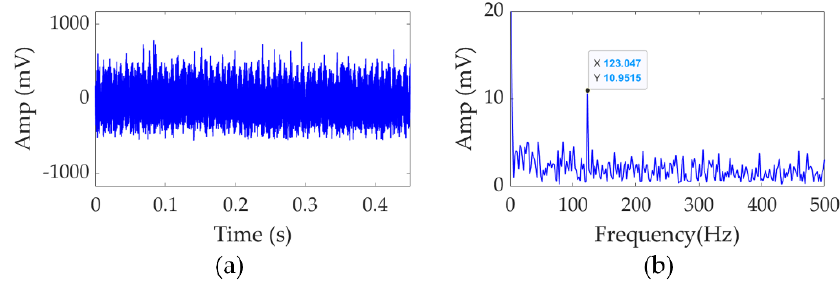
Figure 5. Learned dictionary atoms.